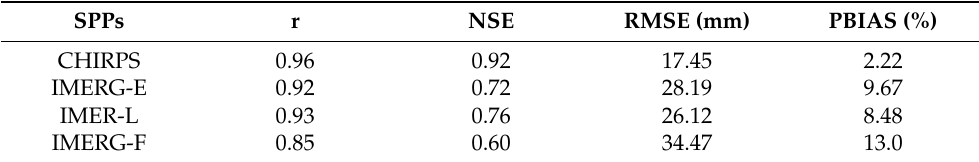
Table 3. Monthly statistical performance evaluation satellite rainfall products for the Ziway Lake Basin.